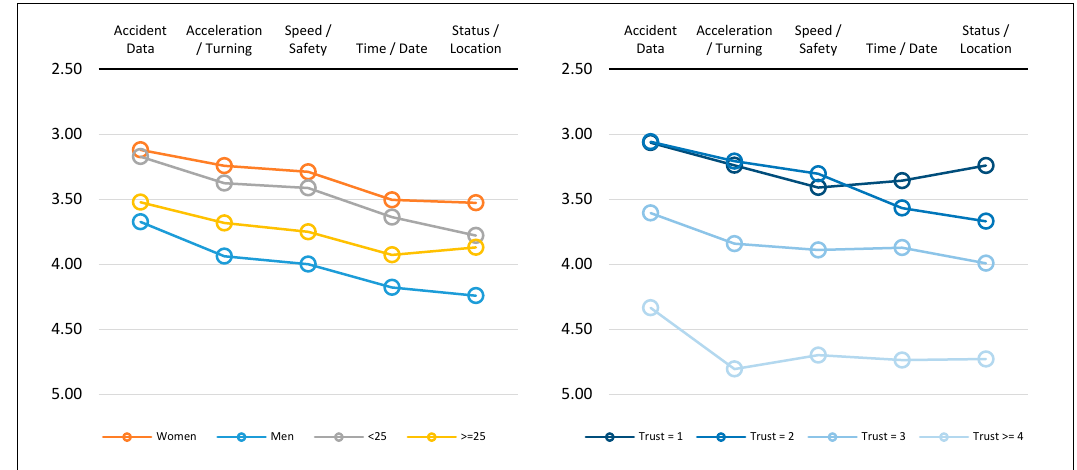
Figure 3. Willingness to share by type of benefit and type of information.